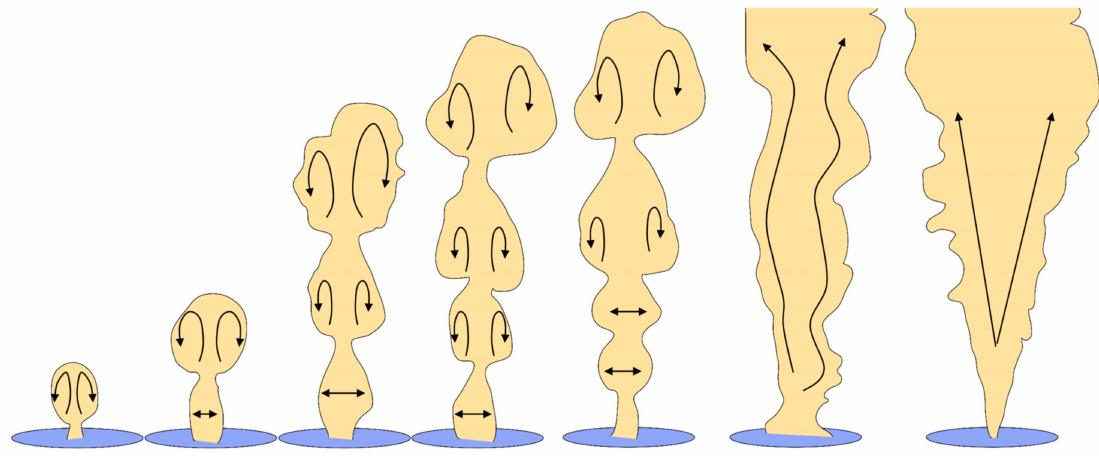
Figure 13. Revolution of the gas-water interface.